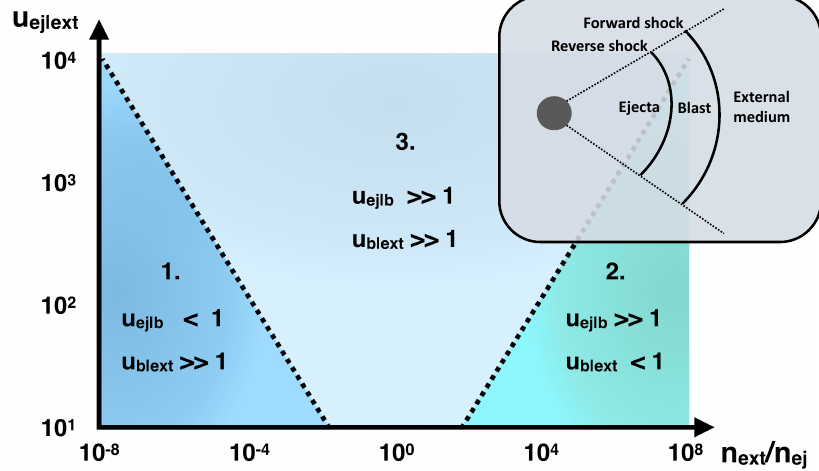
Figure 1. Phase diagram of relativistic ejecta ( | u ej | ext | ≥ 10 ) penetrating the external medium in